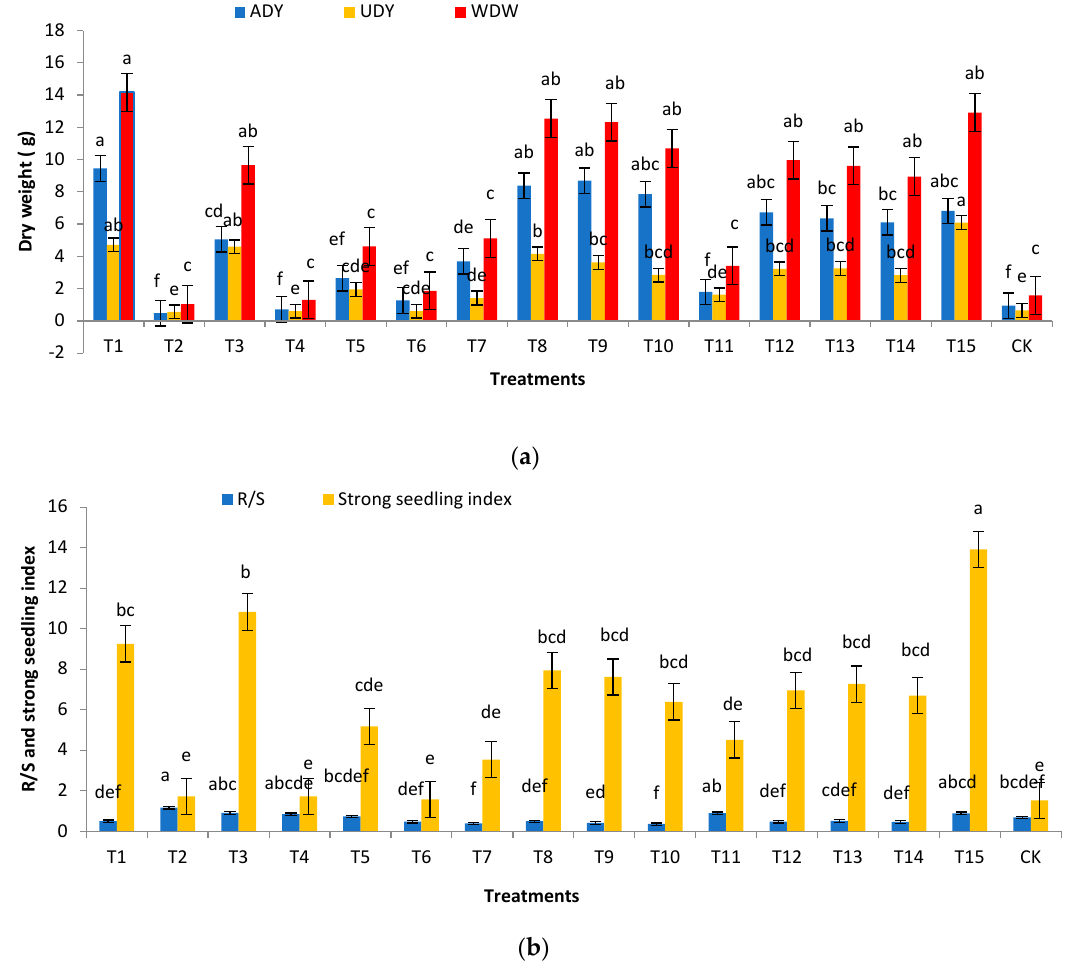
Figure 2. Biomass of H. chrysanthus with different mixed substrates: ( a ) aboveground dry weight (ADW, g), underground dry weight (UDW, g), and whole-plant dry weight (WDW, g); ( b ) root stem ratio (R/S) and strong seedling index. Significant differences between treatments are indicated by different lowercase letters (Tukey’s HSD test; p < 0.05; mean ± SE).